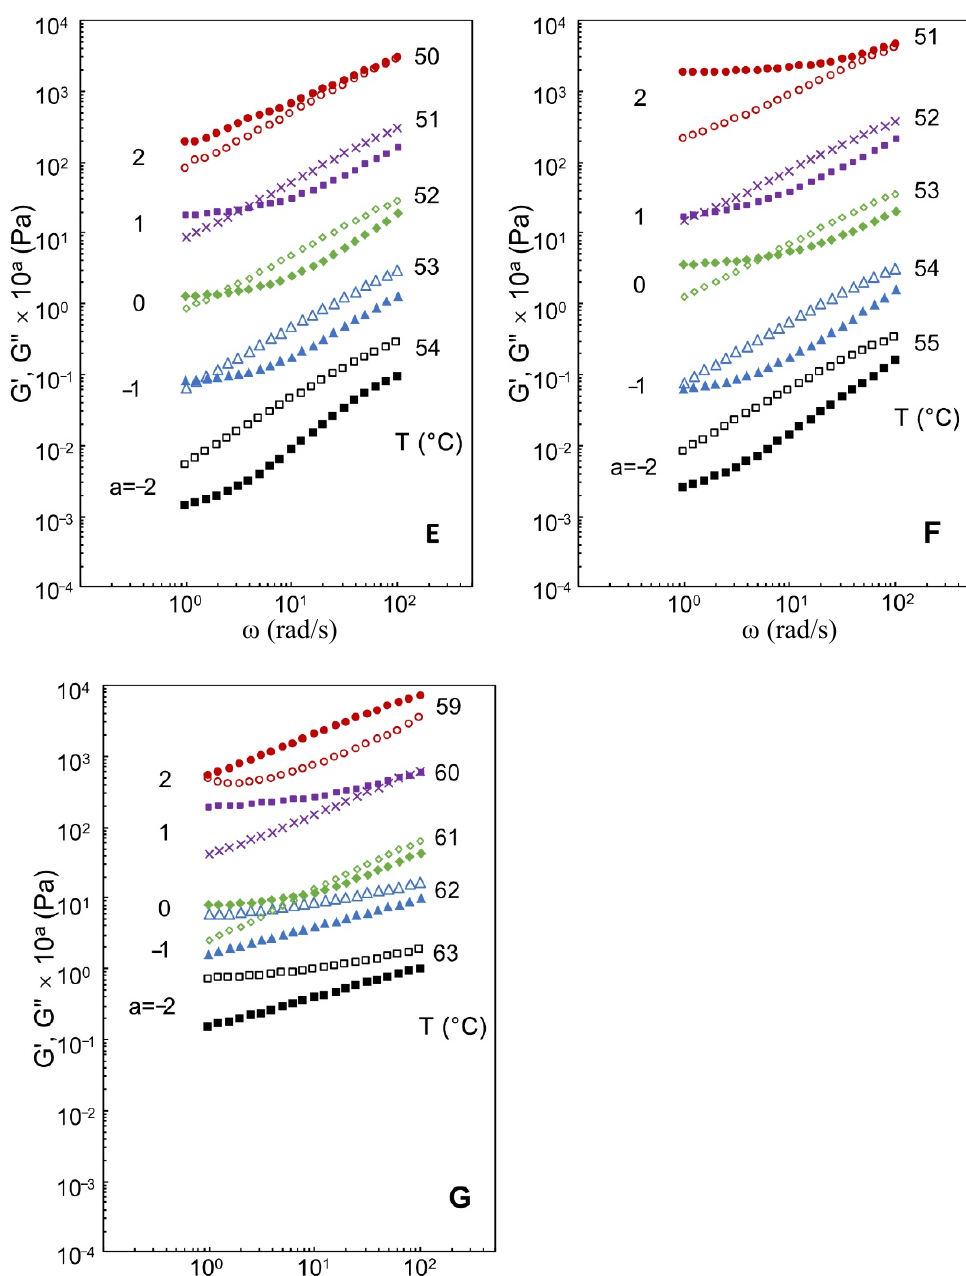
ω (rad/s) Figure 2. The values of G ′ (solid symbols including ■ , π , ♦ , ■ , and ● ) and G ″ (open symbols including □ , △ , ◇ , × , and ○ ) at different temperatures for 2 wt% κ -carrageenan ( κ -C) with the addition of ( A ) 0 wt% xylitol and maltitol; ( B ) 10 wt% xylitol addition; ( C ) 20 wt% xylitol addition; ( D ) 30 wt% xylitol addition; ( E ) 10 wt% maltitol addition; ( F ) 20 wt% maltitol addition; and ( G ) 30 wt% maltitol addition. The values in figures indicated the data were calculated to move by a factor of 10 a vertically.